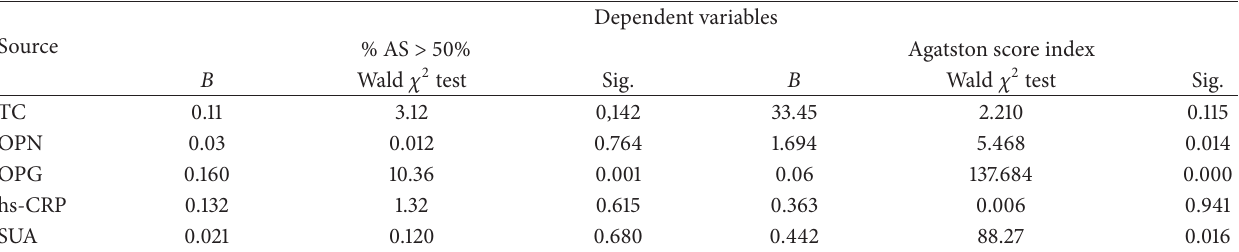
Table 3: Tests of generalized regression model for five parameters (total cholesterol, osteopontin, osteoprotegerin, high-sensitive C-reactive protein, and serum uric acid) that potentially contributed to calcification of coronary arteries after excluding type two diabetes